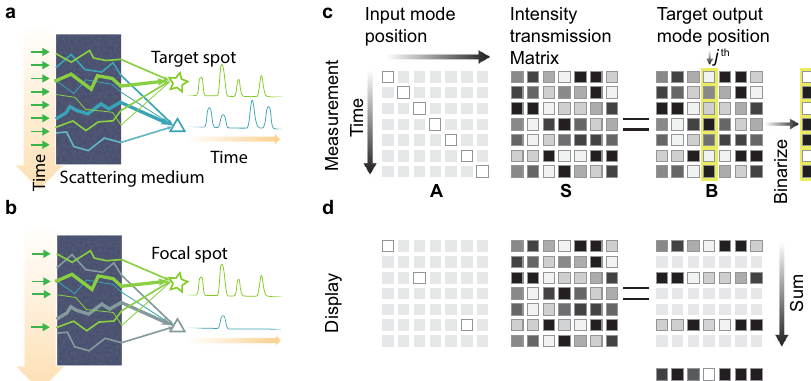
Fig. 2 Principle of feedback-based OCIS. a Coherent light source scans across the input plane of the scattering medium over time, resulting in time- varying intensity signals at the target spot on the target plane. At another spot (denoted by a triangle), the signals are uncorrelated with those at the target spot due to the random scattering of the light through the sample. These time-varying signals allow us to map the optical channels between the input and the target plane. b By injecting light into the channels that connect to the target spot, a focus pattern is formed at the target spot while other spots on the target plane receive less light on average. c , d Matrix representation of the feedback-based OCIS. c The incident optical mode sweeps through space over time, and can be represented by an identity matrix A . Its interaction with the scattering medium is represented by multiplying the intensity transmission matrix S , resulting in time-varying speckle patterns on the output. The measurement of the time-varying speckles at the target position is equivalent to taking one column of the intensity matrix B . d During display, the binarized output selects a number of rows of S as output. The integration of the selected output rows over time results in an optical focus pattern at the target